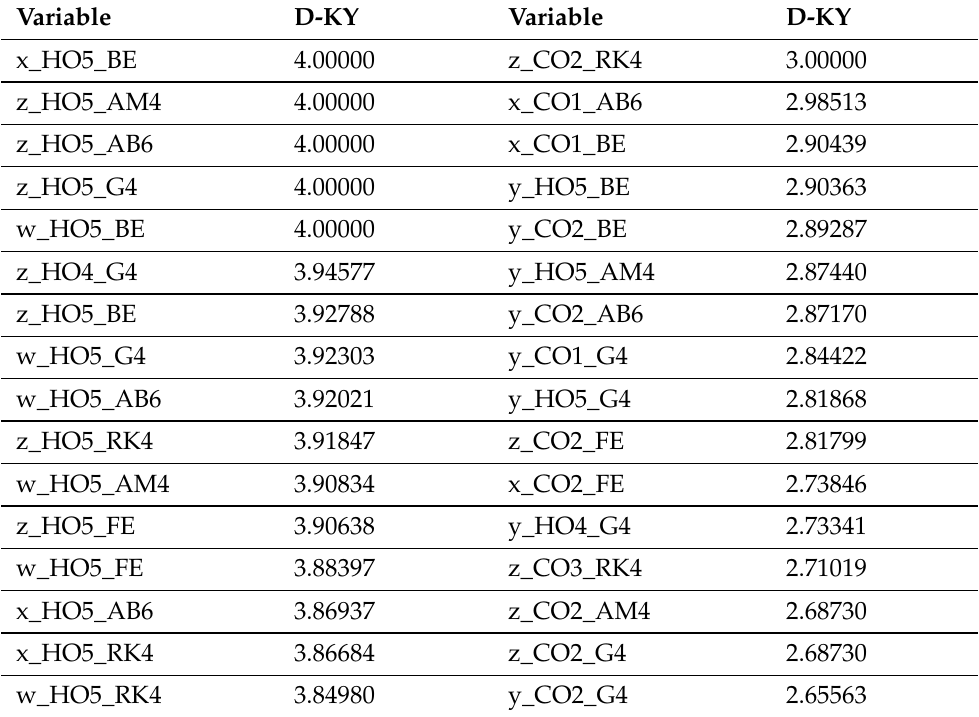
Table 5. D KY (ordered from the highest to the lowest) evaluated by TISEAN for each state variable of the five oscillators given in Table 1, and for each numerical